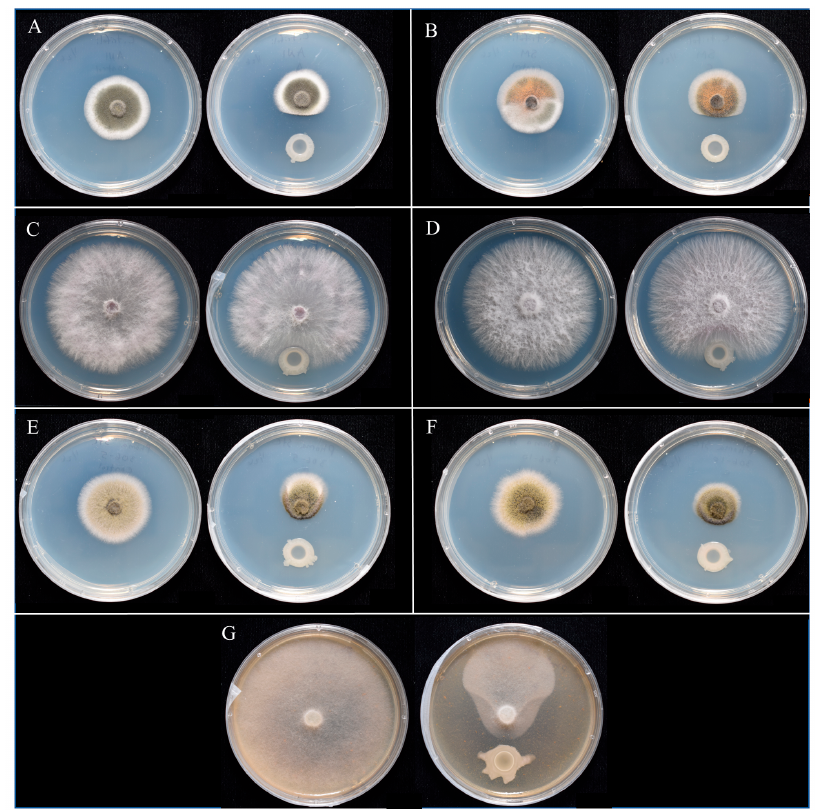
Figure 1. Results of UD1022 direct antagonism assays. Control (left) and treatment plate (right) pairs for each pathogen challenged. ( A ), Colletotrichum trifolii AN1. ( B ), Colletotrichum trifolii SM. ( C ), F. oxysporum f. sp. medicaginis Fom3. ( D ), F. oxysporum f. sp. medicaginis Fom255. ( E ), Ascochyta medicaginicola StC 306-5. ( F ), Ascochyta medicaginicola StC 306-10. ( G ), Phytophthora medicaginis A2A1. UD1022 had no antagonism toward either strain of F. oxysporum f. sp. medicaginis (FOM 255 and Fo 3). The greatest antagonism was toward A. medicaginicola and P. medicaginis . UD1022 antagonism was significant toward both A. medicaginicola strains, 63% toward StC 306-5 and 55% towards StC 306-10 (Figure 1E,F). The strain StC 306-5 was selected for further analysis of UD1022 antagonistic mechanisms through the use of select UD1022 functional deletion mutants in NRP and biofilm pathways. UD1022 antagonism against P. medicaginis A2A1 was the strongest, reducing colony area by 67% (Figure 1G) and A2A1 was subjected to further analysis to identify a mechanism for the observed activity. UD1022 NRP mutant srfAC − had a moderate but significantly less antagonistic effect (35% inhibition) on A . medicaginicola StC 306-5 colony area than UD1022, at nearly 48% inhibition ( p = 0.044). Colony areas of StC 306-5 responding to ppsB − had 44% inhibi- tion and the double-mutant ppsB − - srfAC − treatment was intermediately inhibited at 39%. Both were statistically similar to the UD1022 treatment ( p = 0.853 and 0.265, respectively) and to srfAC − ( p = 0.27 and 0.859, respectively). The fungal colony area response to mutant sfp − was not different from the fungal colony in response to UD1022 with 53 % inhibition ( p = 0.766) (Figure 2). The direct challenge with surfactin at concentrations of 25 and 100 µ g/mL resulted in observable but not significant antagonism of StC 306-5 (Supplementary Figure